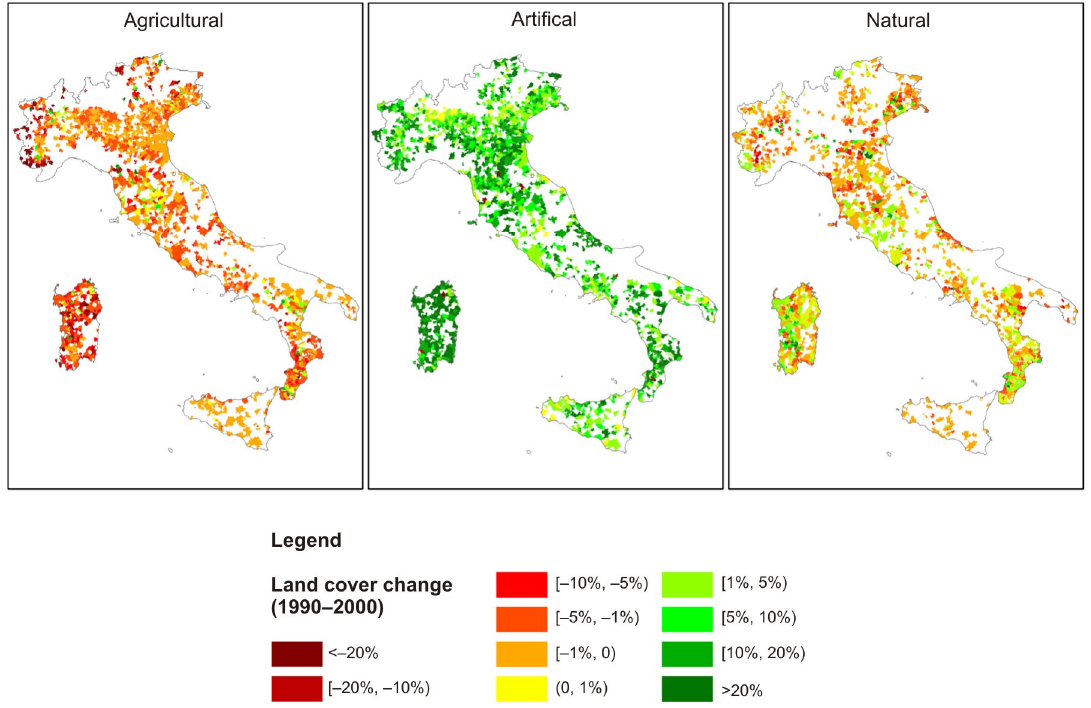
Fig. 1. Percent land cover change by municipality (1990–2000); smoothed rates using locally weighted estimator with 5-km radius; areas represented in white experienced no